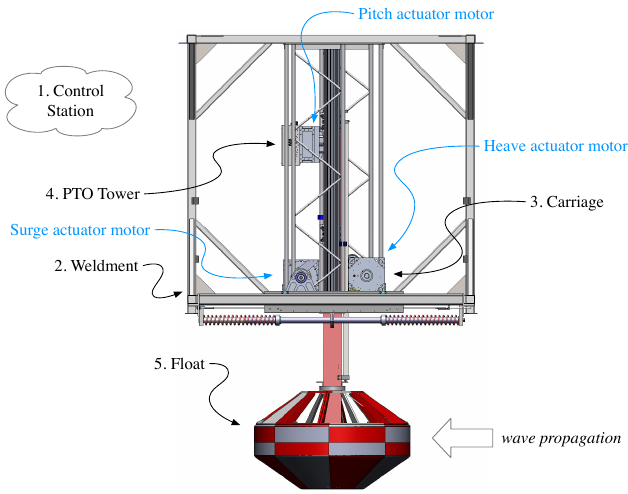
Fig. 1: Simplified diagram of the 3-DOF WaveBot de- vice, axi-symmetric about the z (heave) axis [15]. flat bottom to the top of edge of the cylindrical surface (indicated with the red-white grid) of 0.73 m. In calm water, the free-surface of the device is 0.20 m below the top of the cylindrical surface. The rigid-body mass of